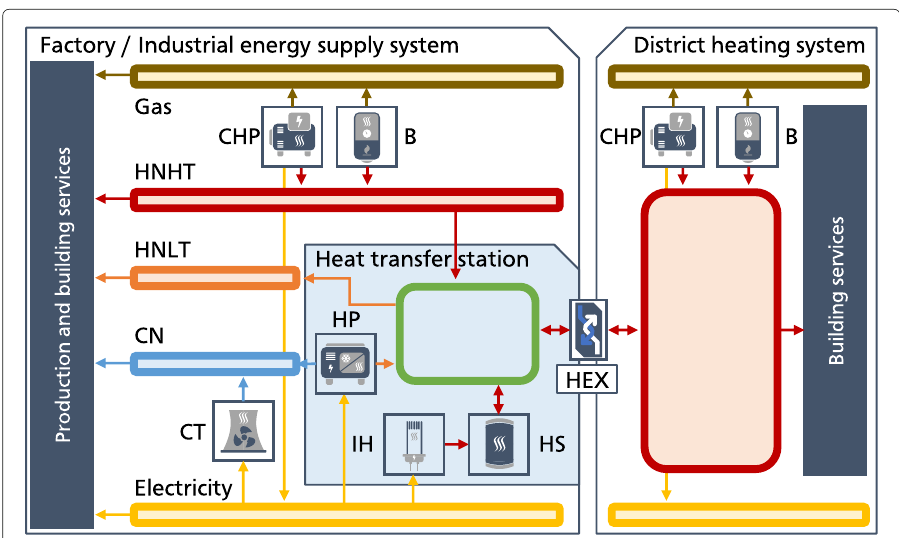
Fig. 1 Industrial heat transfer station as an autonomous subsystem of an industrial energy supply system, flexibly connecting the industrial site with the district heating